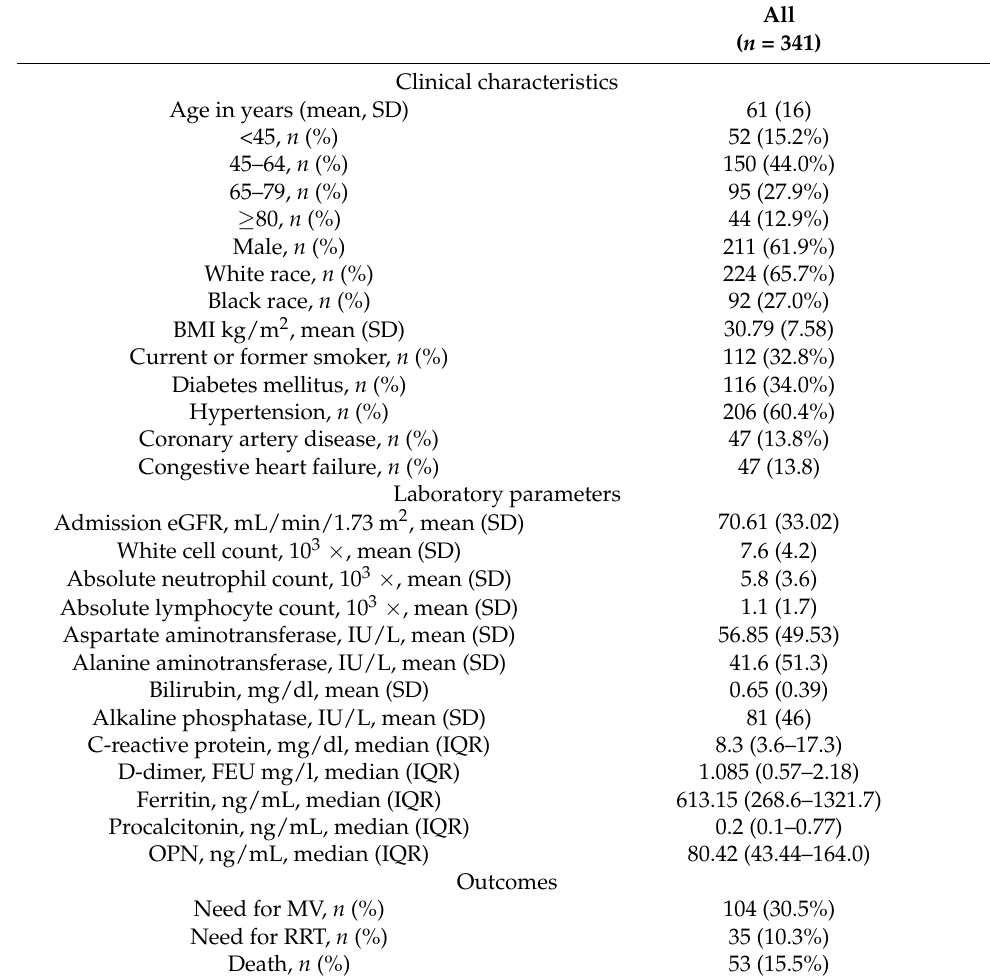
Table 1. Clinical characteristics of the study